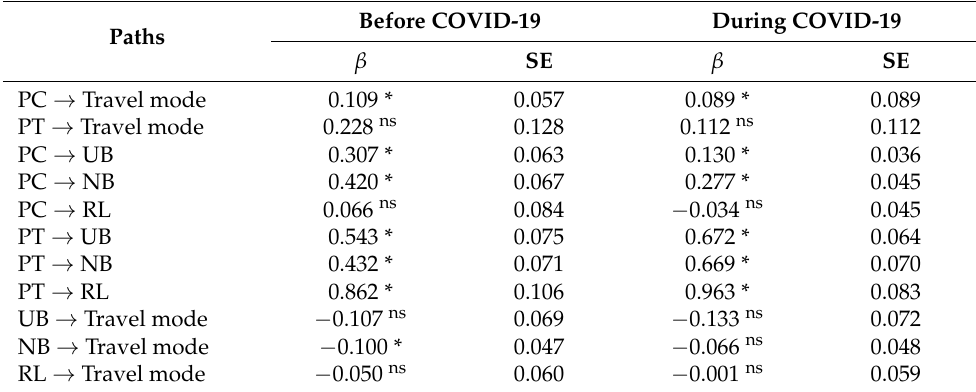
Table 5. Direct path of structural